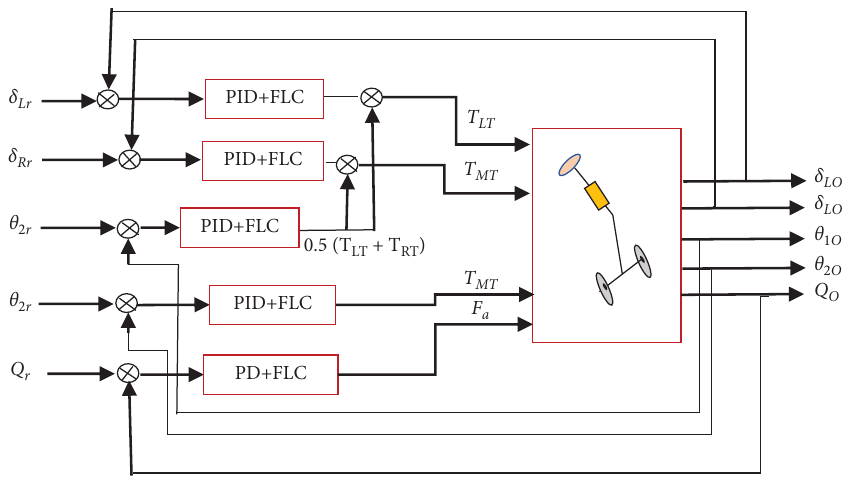
Figure 2: Te system block diagram using hybrid controllers. Table 2: PID and PD gain parameters.